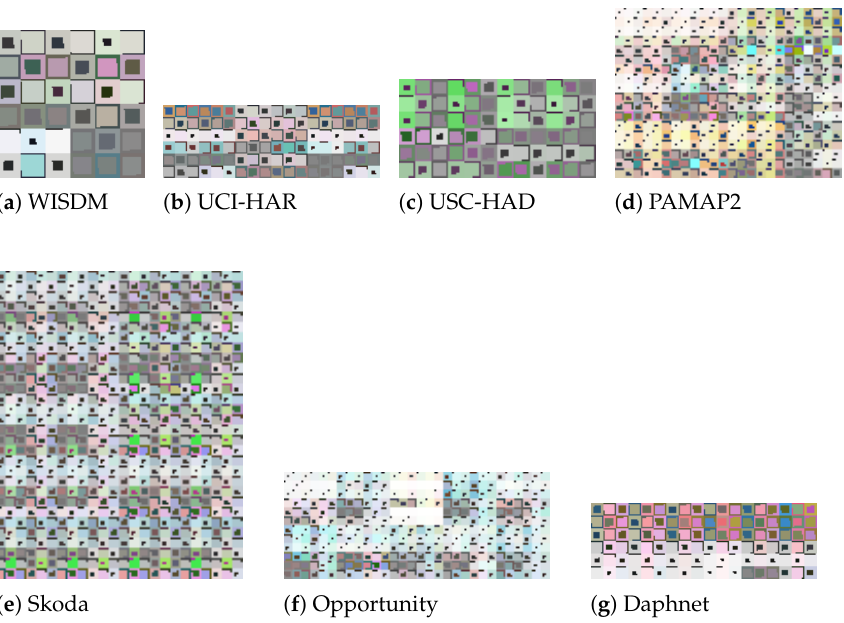
Figure 11. Samples of the image representations: ( a ) WISDM (120 × 120 px.), ( b ) UCI-HAR (180 × 60 px.), ( c ) USC-HAD (120 × 60 px.), ( d ) PAMAP2 (120 × 90 px.), ( e ) Skoda (120 × 150 px.), ( f ) Opportunity (150 × 60 px.), and ( g ) Daphnet (180 × 60